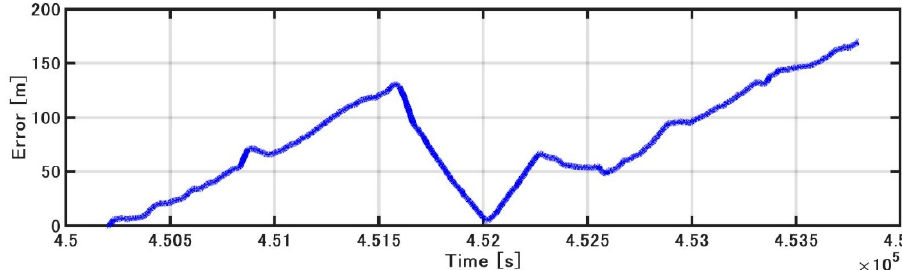
Figure 18. Horizontal error.